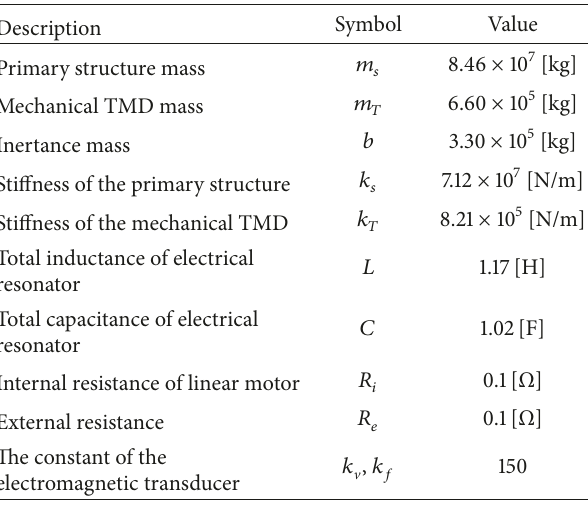
Table 1: The parameters of